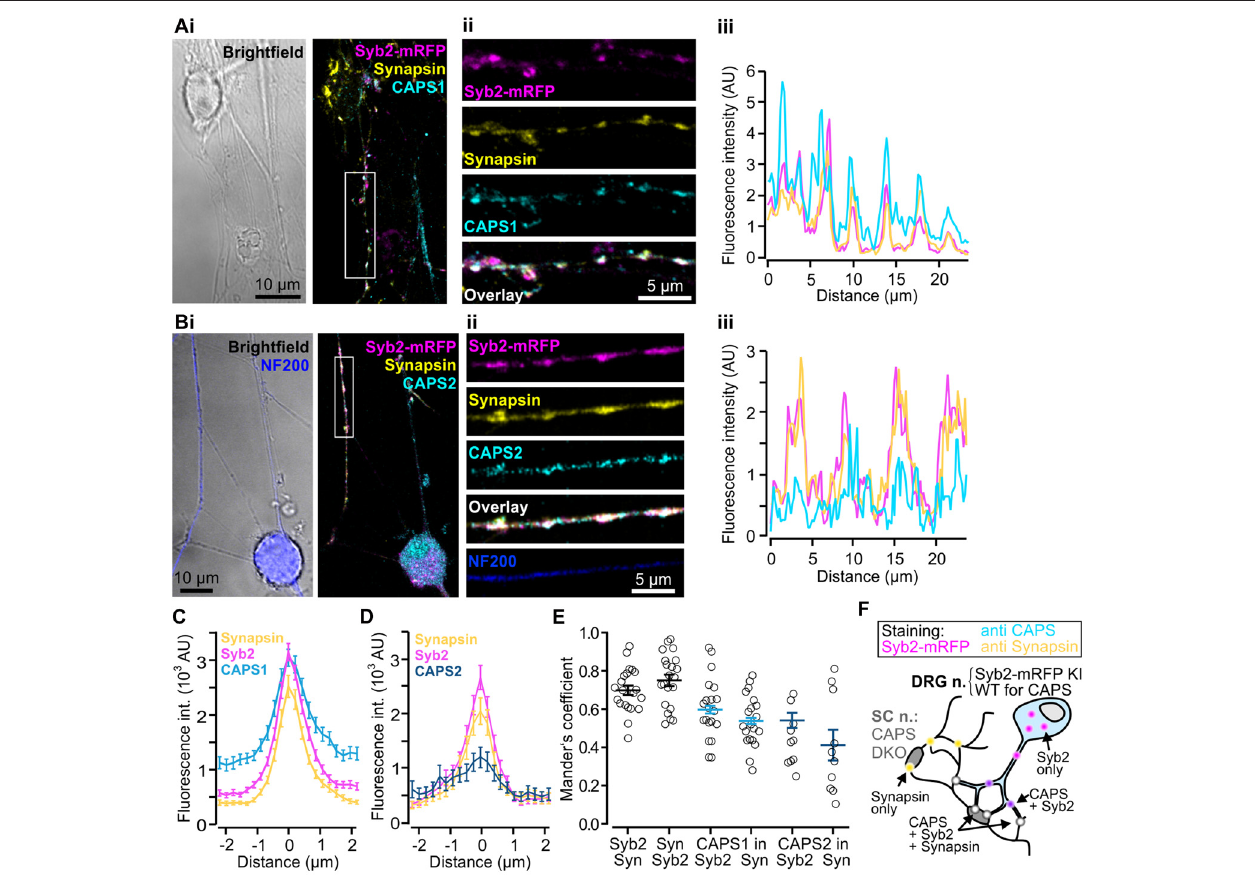
FIGURE 5 | CAPS1 is localized to synapses. Co-cultured adult Synaptobrevin2-mRFP (Syb2-mRFP) knock-in DRG neurons with E18 CAPS DKO spinal cord (SC) neurons were fixed with 4% paraformaldehyde at day in vitro (DIV) 7 and stained with antibodies directed against CAPS1 or CAPS2 and synapsin to mark synapses. This culture condition ensured that anti-CAPS labeling was localized to DRG and not SC interneurons (SC neurons) and that DRG neurites could be readily identified by Syb2-mRFP red fluorescence. (Ai) Left: bright field image of one SC neuron and a network of neurites. Right: overlay of a maximal intensity projection (MIP) image of Syb2-mRFP (magenta), synapsin (yellow) and CAPS1 (cyan) labeling. (Aii) Enlarged portion of a neurite outlined in (Ai) . The individual channels (Syb2-mRFP, synapsin and CAPS1) and their overlay are displayed from top to bottom. (Aiii) Line profile along the neurite presented in (Aii) . Note that CAPS1 is enriched at synapses (puncta in which Syb2-mRFP and synapsin co-localize). (Bi) Left: overlay of a bright field image and anti-neurofilament 200 (NF200; blue) labeling of a peptidergic DRG neuron. Overlay of a MIP image of Syb2-mRFP (magenta), synapsin (yellow) and CAPS1 (cyan) labeling. (Bii) Enlarged portion of a neurite outlined in (Bi) . The individual channels (Syb2-mRFP, synapsin and CAPS1), their overlay, and the NF200 labeling are presented from top to bottom (Biii) Line profile along the neurite shown in (Bii) . (C) Average line profile diagram for CAPS1 over synapses that were selected according to co-localized high fluorescence intensities of the Syb2-mRFP and synapsin signals ( n = 130). (D) Average line profile diagram over synapses for CAPS2, Syb2-mRFP and synapsin ( n = 31). (E) Co-localization was tested with Manders’ coefficient measured on isolated neurites of DRG neurons. Localizations of Syb2-mRFP to synapsin and its inverse, CAPS1 to Syb2-mRFP and CAPS1 to synapsin, CAPS2 to Syb2-mRFP and CAPS2 to synapsin are presented. Averages are indicated as a black line with SEM ( n = 21 and 10 for CAPS1 and CAPS2, respectively). (F) Schematic representation of the experimental design. Yellow dots indicate SC-SC neuron homotypic synapses in which, by design, only synapsin can be observed. Magenta dots likely correspond to SVs or LDCVs at extra-synaptic locations. CAPS1 was found at low levels throughout the DRG-neuron (light blue, see (B,C) ) and enriched at heterotypic synapses (white dots) but can also co-localize with Syb2-mRFP (violet